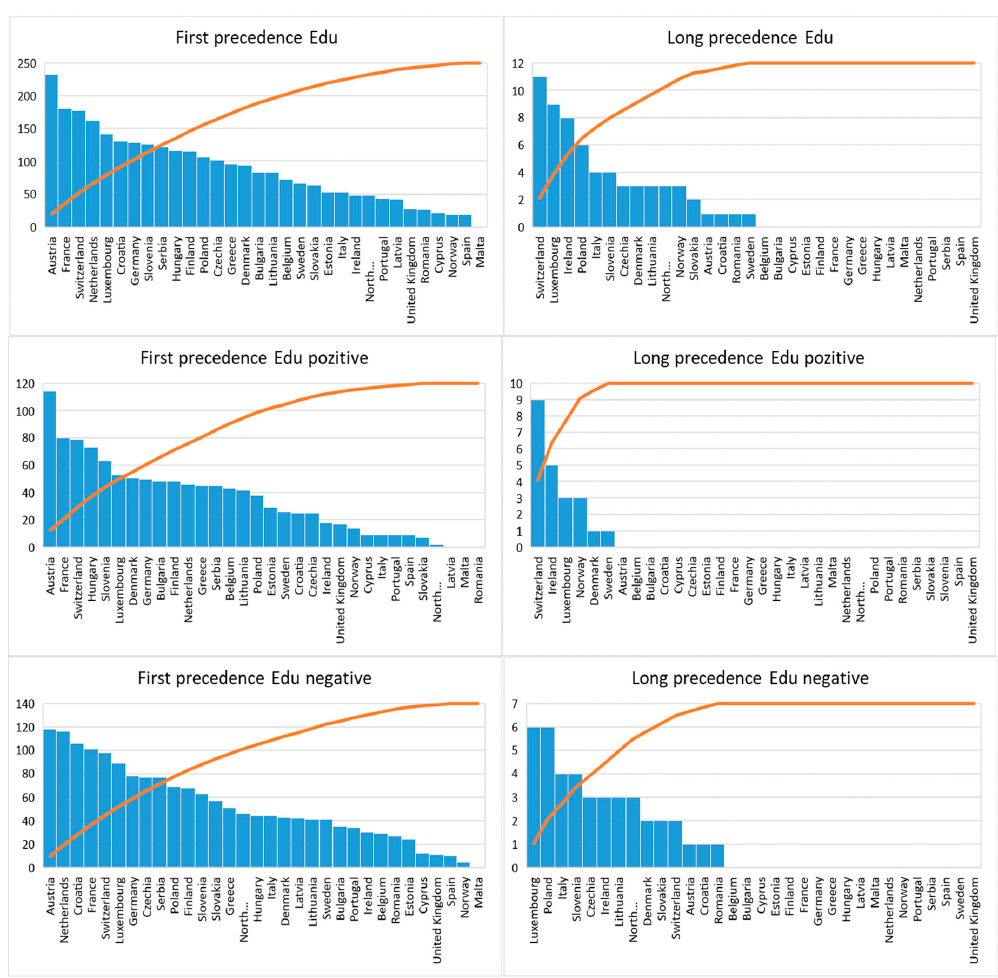
Figure 14. Number of precedence by country, first and long precedencies, grouped Edu by e ff ect.